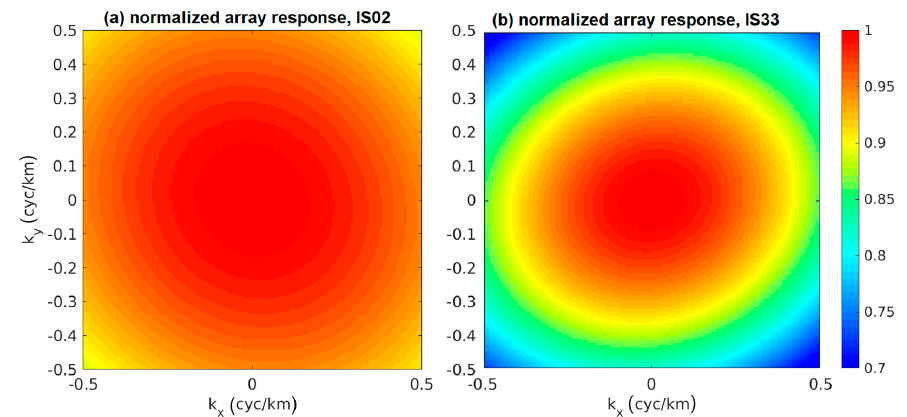
Figure 10. Array response of ( a ) the five-sensor array IS02, and ( b ) the four-sensor array IS33, as functions of the horizontal wave numbers (k x and k y ). The response at IS02 is more blurred in the frequency range of interest, compared to IS33.